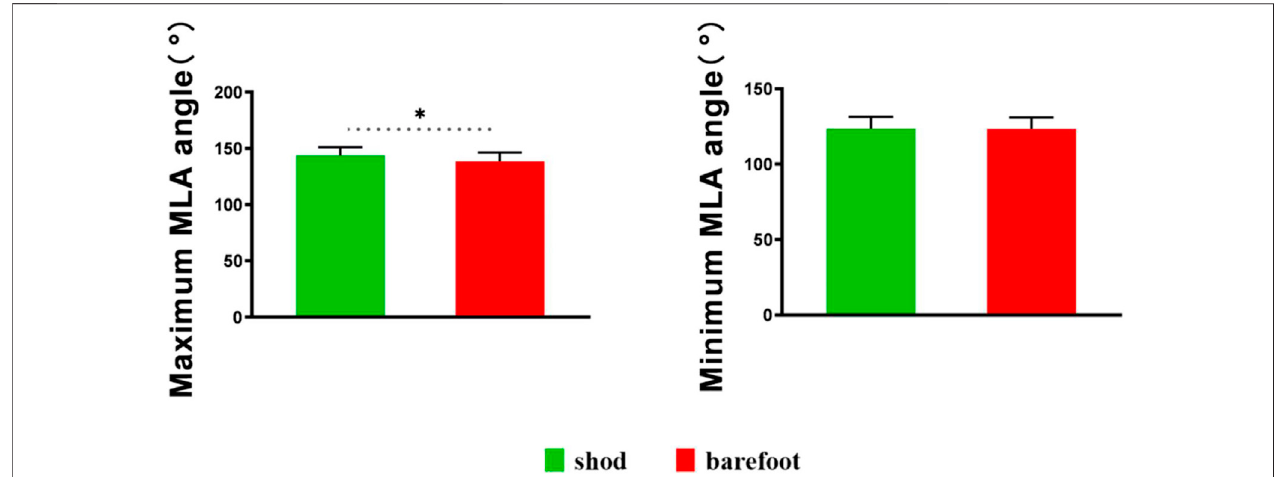
FIGURE 9 | Maximum and minimum MLA angles in shod and barefoot conditions. *: signi fi cant differences existed between the shod and barefoot conditions, p < 0.05.